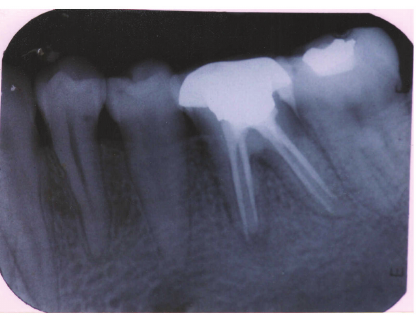
Figure 10: With crown